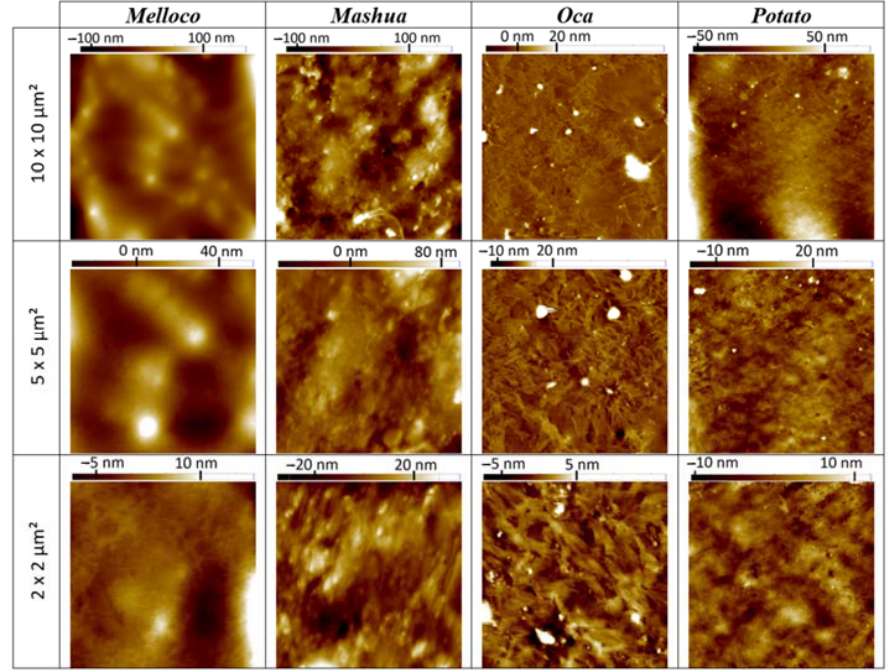
Figure 5. Topographic atomic force microscopy images measured using tapping mode on the surface of biofilms extracted from each Andean tuber studied at different scan area ranges.